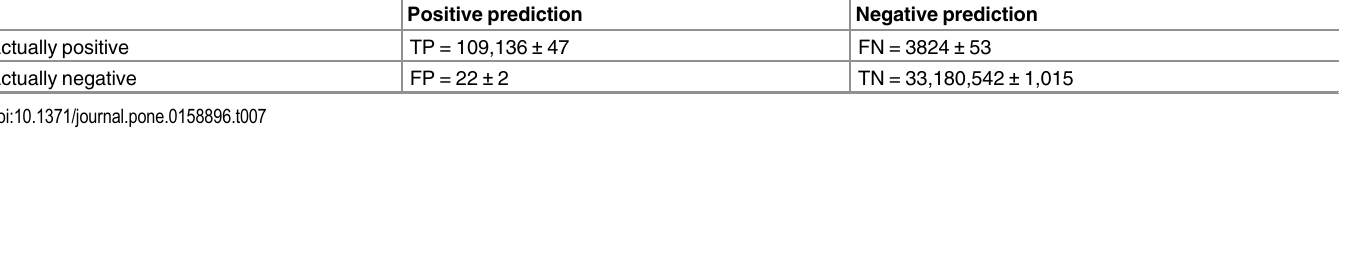
Table 7. Performance evaluation of our system as illustrated by a confusion matrix. Results are averaged over two-run five-fold-cross-validation along with the corresponding deviation values ( ± d ) from the observed values of the two runs. Positive